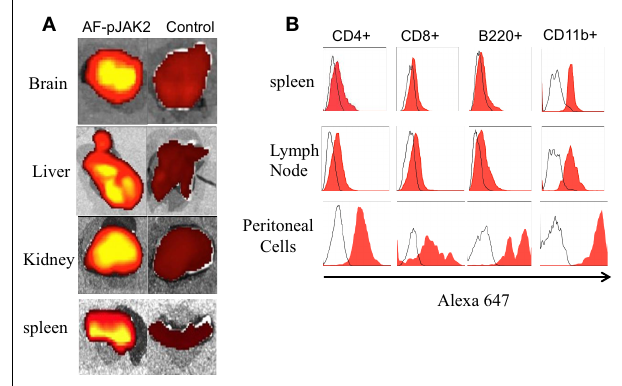
FIGURE 4 | Tissue and immune cell localization of Alexa Fluor 647 conjugated lipo-pJAK2 (AF-pJAK2) peptide . Lipo-pJak2 was conjugated to the fluorochrome Alexa 647 (Invitrogen). AF-pJAK2 or unconjugated fluorochrome was injected into C57BL/6 mice i.p., followed by sacrifice of the mice 2h later. Brain, liver, kidney, spleen, lymph node, and peritoneal cells were subsequently isolated. (A) AF-pJAK2 incorporation into the brain, liver, kidney, and spleen of mice receiving AF-pJAK2 i.p (left) in contrast to mice receiving unconjugated Alexa 647 (FC, right) using a Xenogen IVIS Fluorescence Imager. (B) AF-pJAK2 is incorporated into immune cells. Histograms showing CD4 + , CD8 + , B220 + , and CD11b + leukocytes present within the spleen, lymph node, and peritoneal cavity of AF-pJAK2-injected mice that stained positive for AF-647 (red) when compared to leukocytes isolated from mice receiving unconjugated AF-647 i.p. (uncolored histogram). Data are representative of two independent experiments with four mice in each